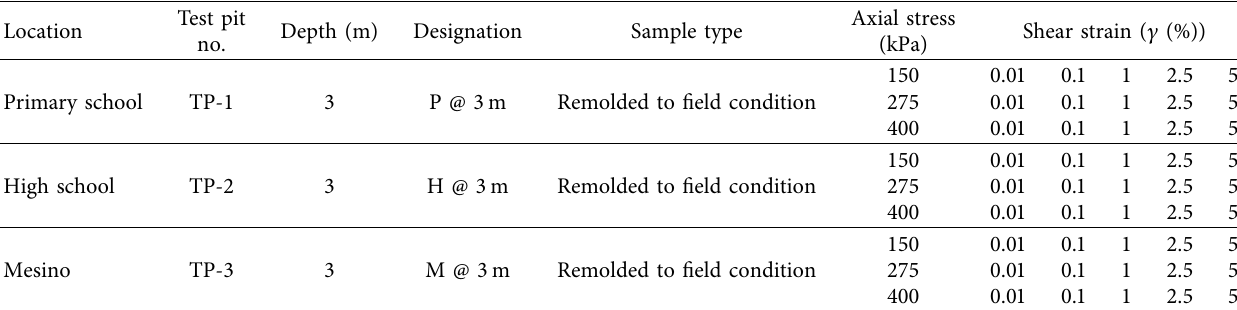
Figure 2: (a) 31-WF7500 model cyclic shear machine and (b) fxing the loading ram on the top of the specimen. Table 2: Axial stress and shear strain values are used for the cyclic simple shear